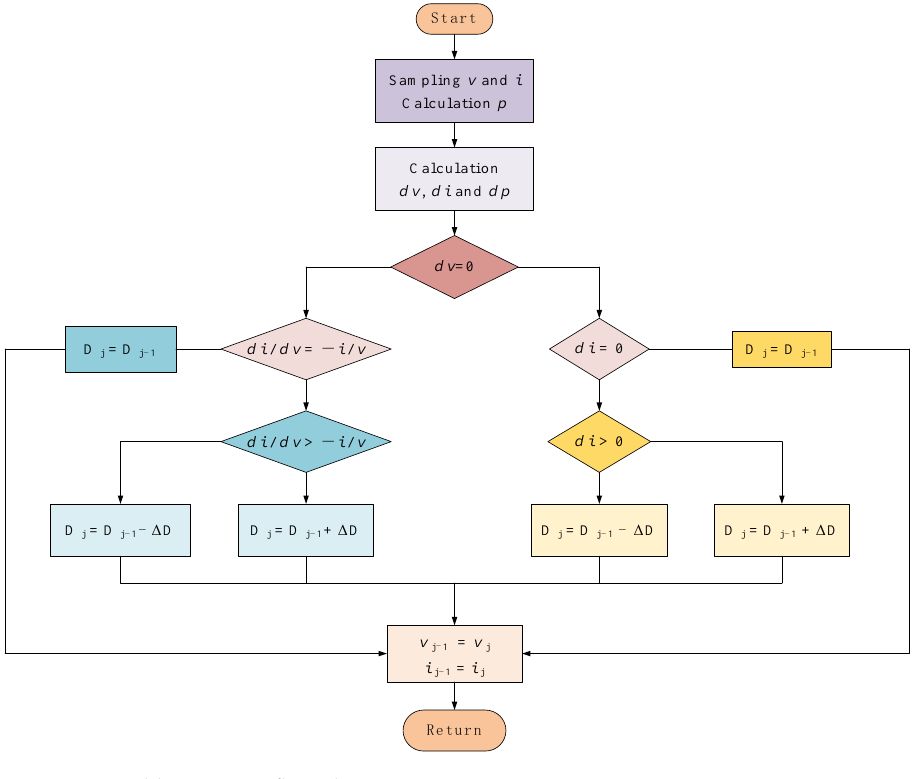
P o w e r ( k W ) Figure 4. P-V and I-V curves of photovoltaic output under secondary ripple. 2.3. The Improvement of MPPT Algorithm The traditional incremental conductance method often uses a fixed step size, which needs to be weighed in the dynamic response and steady-state oscillation. In order to meet the dynamic response and steady-state output at the same time, the traditional algorithm